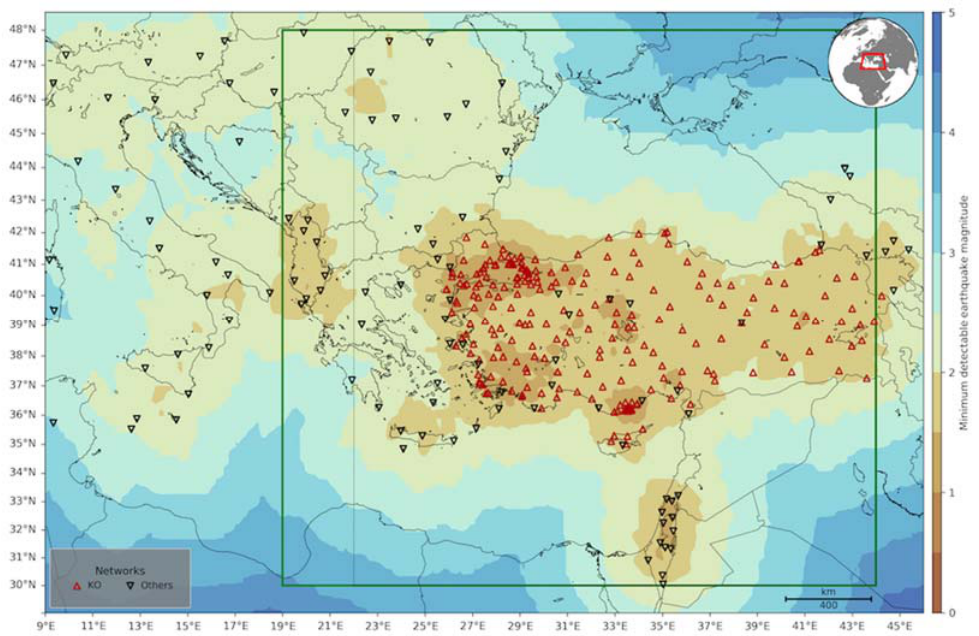
Figure 2. Regional seismic stations available to KOERI-RETMC within its TSP operations area and regional earthquake magnitude threshold map of KOERI–TSP. Red upwards pointing triangles show KOERI’s own seismic stations, whereas black downwards pointing arrows show stations available from other networks. The earthquake monitoring area (dotted line until 2019) is shown with green rectangles.